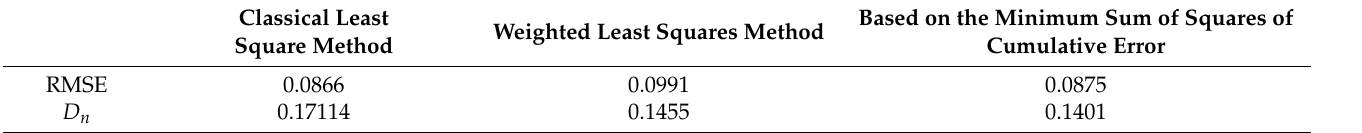
Table 6. Root mean square error and K–S test